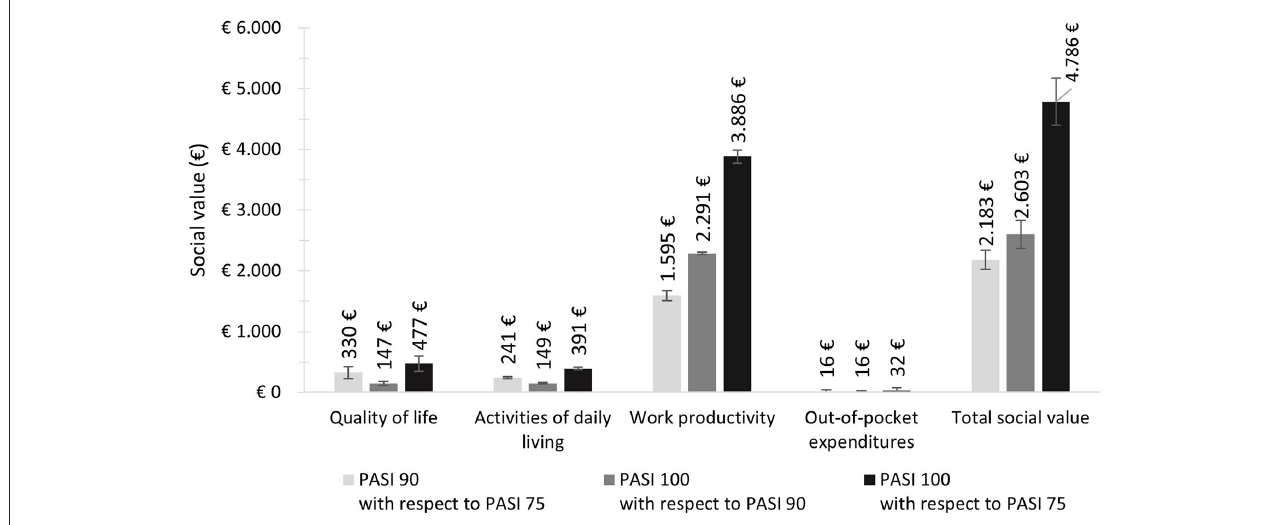
FIGURE2 Potential social value according to PASI scenarios, areas of analysis, and total.